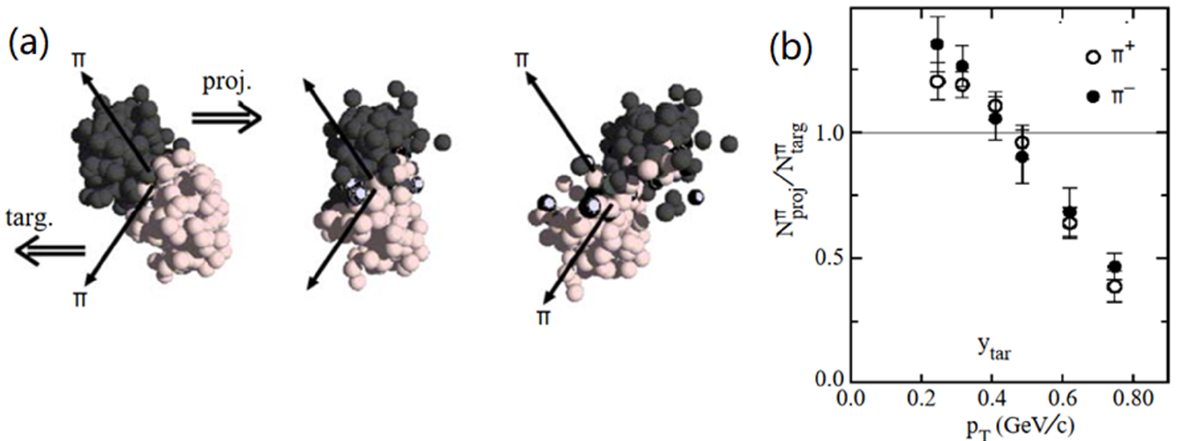
Figure 5. ( a ) Three snapshots of a Au+Au collision with a beam kinetic energy of 1A GeV (impact parameter b = 7 fm) calculated with the QMD transport code for 4 fm/c (left), 10 fm/c (center) and 16 fm/c (right). The pions are emitted in the reaction plane at backward angles corresponding to a particular detector position. ( b ) Pion number ratio N π proj /N π t arg measured as function of transverse momentum in peripheral Au+Au collisions (b ≥ 5.7 fm) at 1A GeV at target rapidity. N π proj and N π t arg denote the numbers of pions emitted to the projectile and to the target side, respectively, within a cone of ±45° [35].